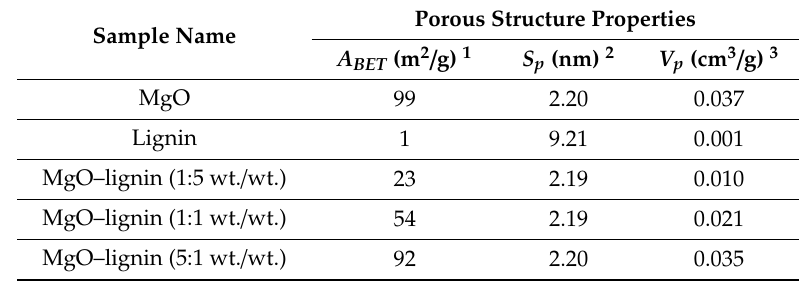
Table 2. Dispersive properties of MgO, lignin, and inorganic–organic hybrid